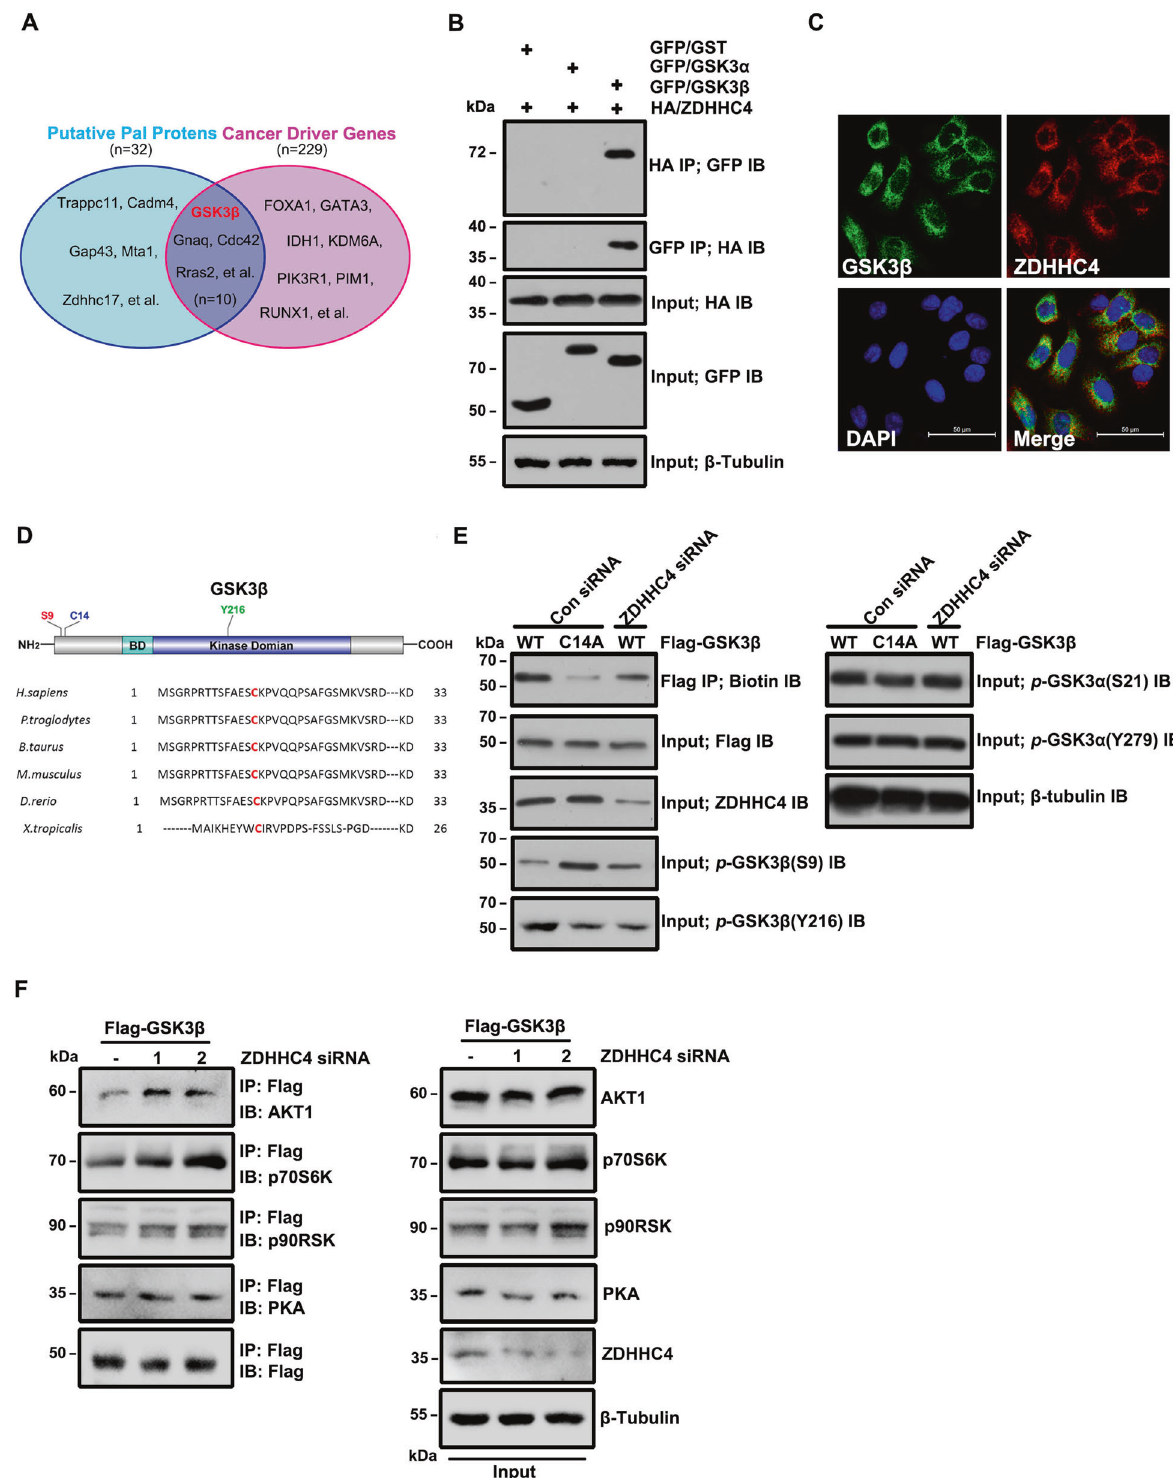
Fig. 1 ZDHHC4-mediated palmitoylation alters GSK3 β phosphorylation. A The collection of palmitoylated proteins and cancer driver genes in GBM. B The interaction of HA-ZDHHC4 with GFP-GSK3 α and GFP-GSK3 β was veri fi ed by immunoprecipitation in 293 T cells. C The localization of ZDHHC4 and GSK3 β in SF126 cells was detected by immuno fl uorescence staining. D Protein map showing the three post- translationally modi fi ed amino acid residues in GSK3 β . E SF126 cells were transfected, and the experiment was divided into three groups: wild- type Flag-GSK3 β , C14A mutant GSK3 β , and wild-type Flag-GSK3 β were simultaneously knocked down ZDHHC4 by siRNA. ABE analysis and phosphorylation of GSK3 α and GSK3 β were performed in the three groups. The experiment was repeated twice. F ZDHHC4 was knocked down by siRNA in SF126 cells with stable expression of Flag-GSK3 β . Immunoprecipitation assays showed the interaction of Flag-GSK3 β with AKT, p70S6K, PKA, and p90RSK.